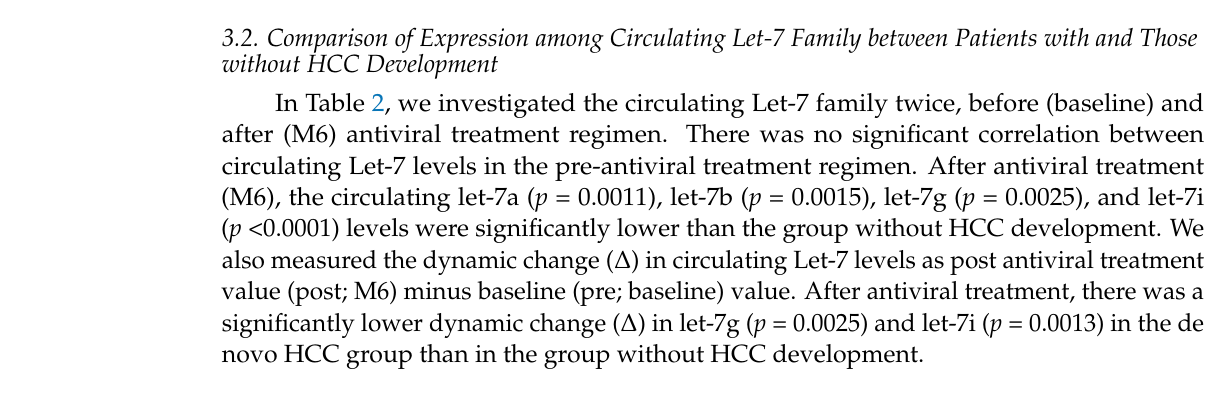
Table 2. Circulating Let-7 family expression at baseline and after anti-viral treatment